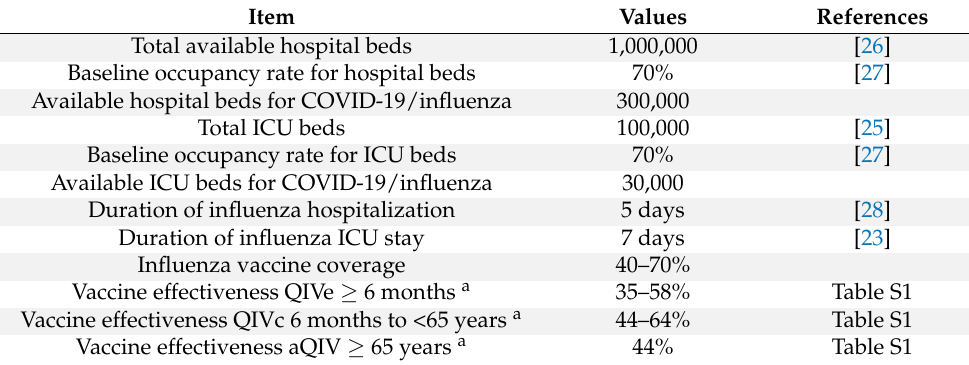
a See Table S1 for details of vaccine effectiveness estimates by age group and vaccine